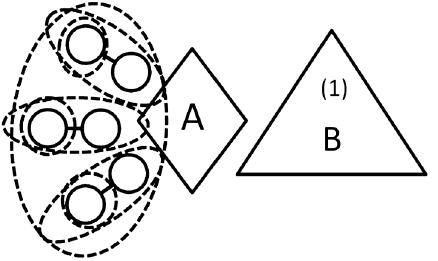
FIG. 3. Pictorial representation of the second relaxation used